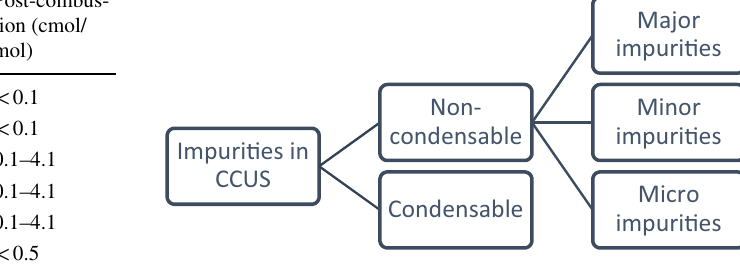
Table 2 Typical Impurities Present in CCUS System (Intergovern- mental Panel on Climate Change 2015; Kather 2009; White et al. 2009) Impurities